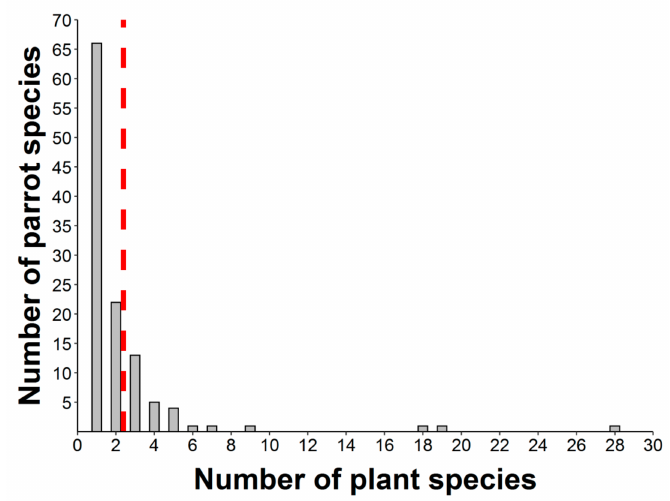
Figure 4. Distribution of the number of epizoochorous interactions between different parrot species and their food plants. Red dashed line shows the mean value of the number of parrot–plant interactions (N = 276).